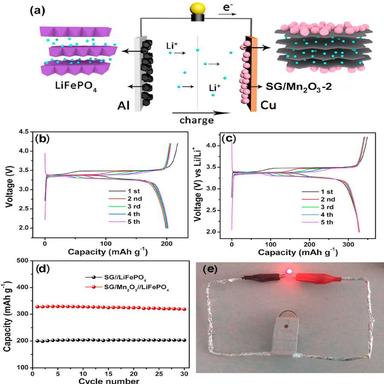
(a) Schematic diagram of the SG/Mn2O3//LiFePO4. Galvanostatic charge/discharge profiles of (b) SG//LiFePO4, (c) SG/Mn2O3//LiFePO4. (d) Cycling performance of SG//LiFePO4 and SG/Mn2O3//LiFePO4. (e) The photograph of the red LEDs lighted up by the SG/Mn2O3//LiFePO4. (For interpretation of the references to colour in this figure legend, the reader is referred to the Web version of this article.)